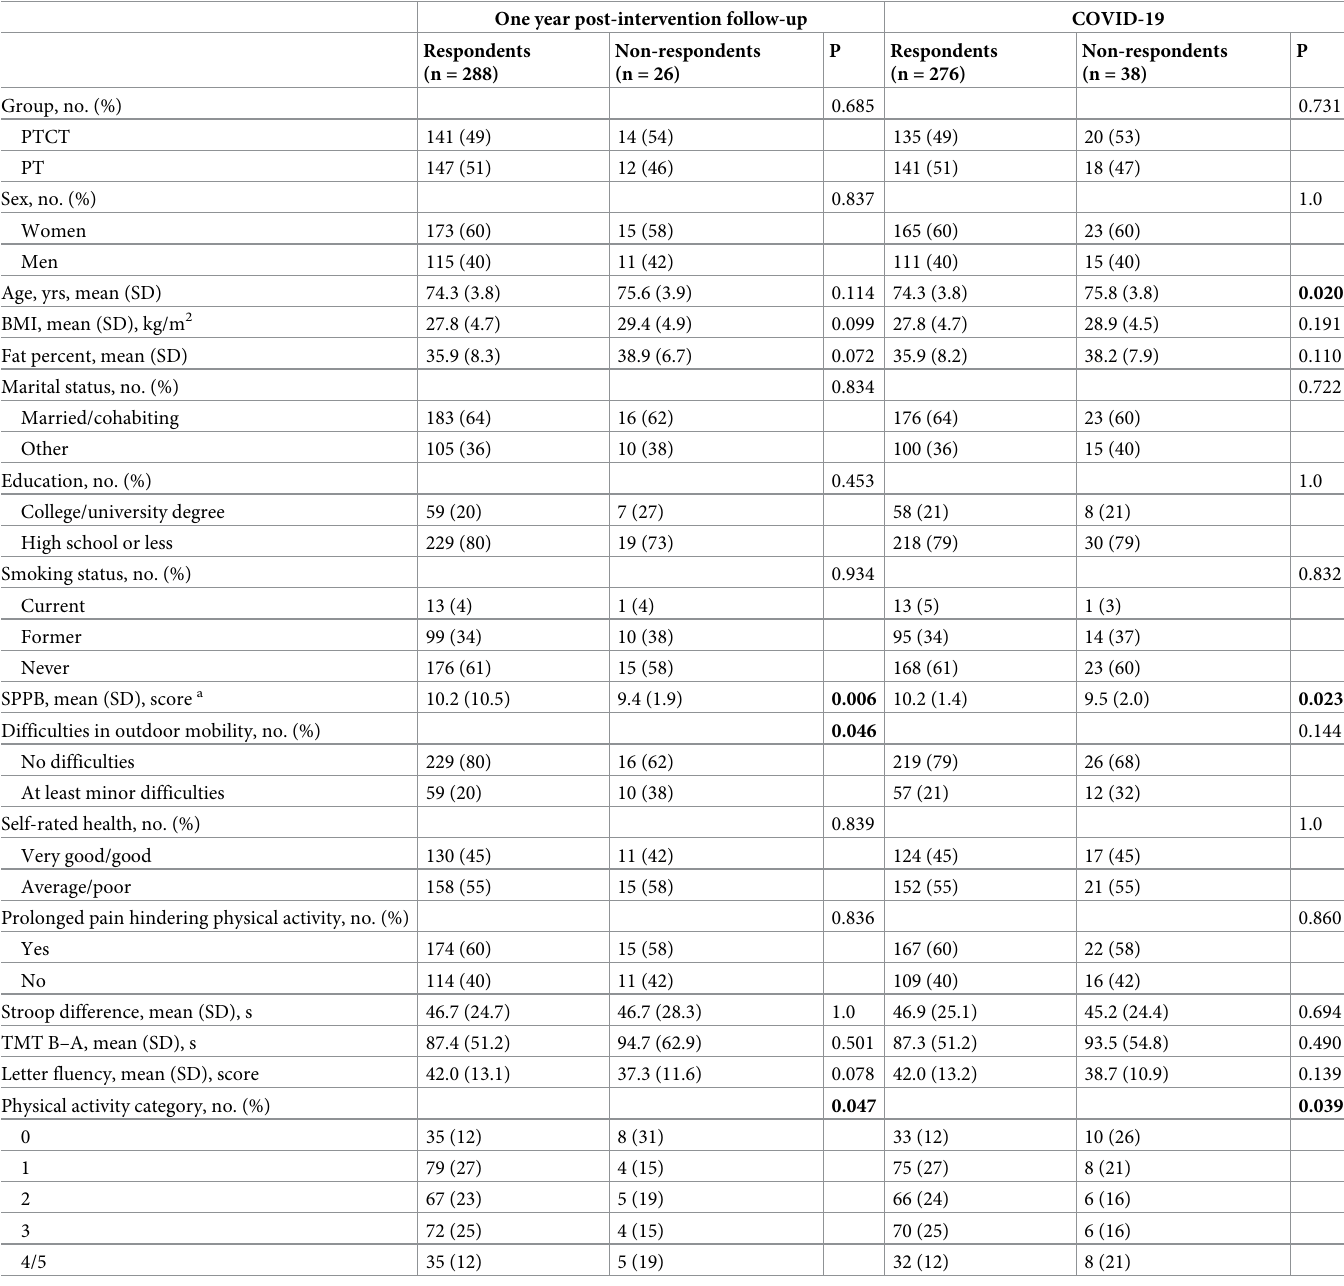
Table 2. Attrition analysis by participants’ baseline